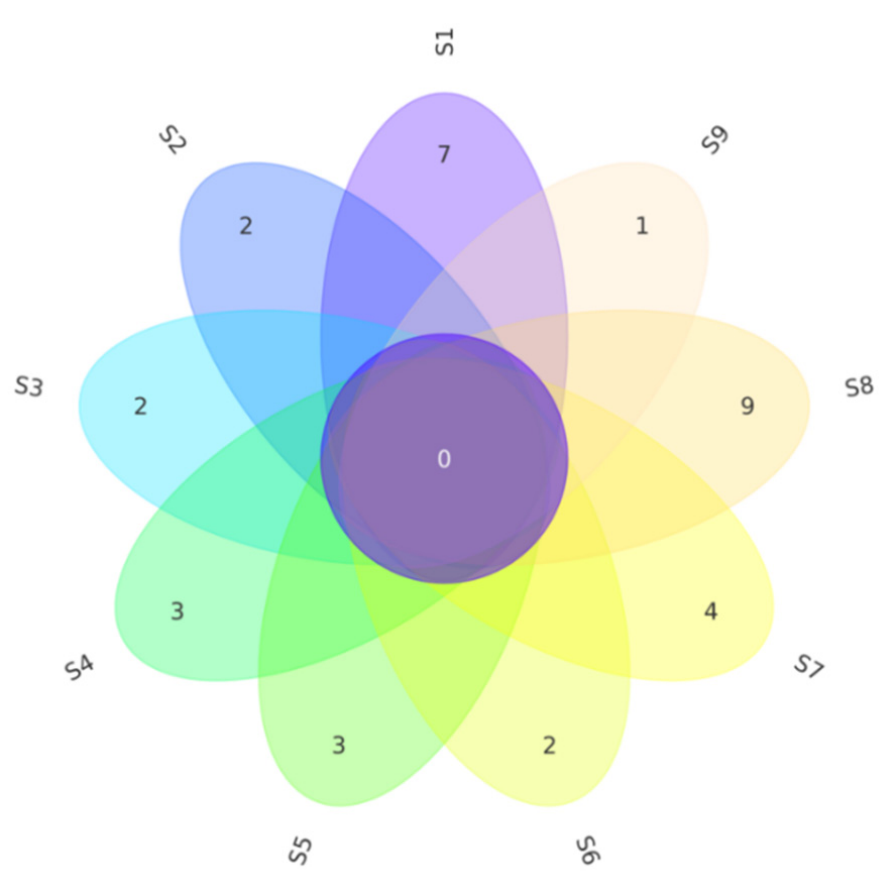
Figure 2. Flower diagram shows the difference of endophytic bacteria among different samples based on culture-dependent